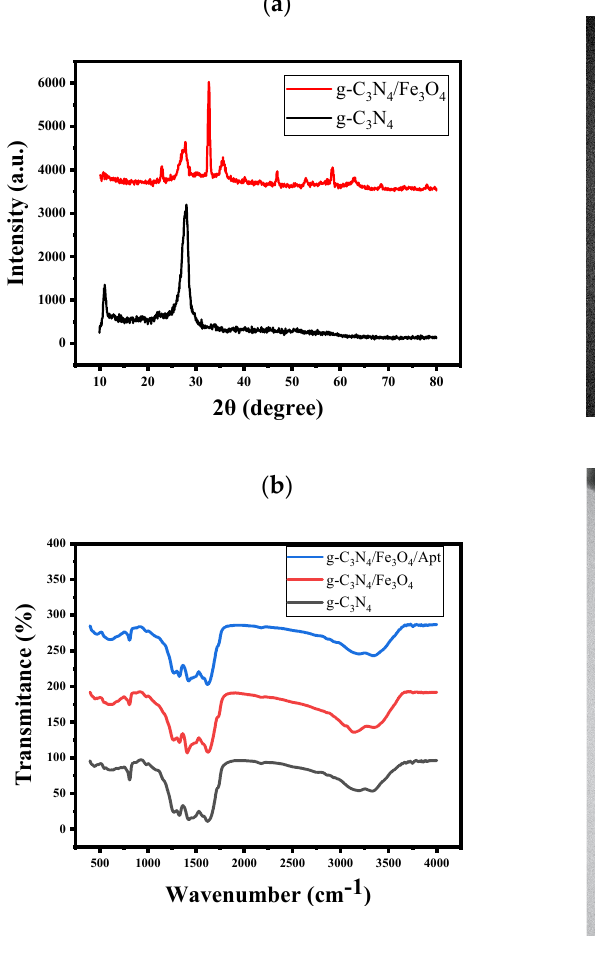
Figure 1. ( a ) X-Ray pattern of g-C 3 N 4 and g-C 3 N 4 /Fe 3 O 4 . ( b ) FTIR spectra of g-C 3 N 4 and g-C 3 N 4 /Fe 3 O 4 and g-C 3 N 4 /Fe 3 O 4 /Apt. ( c ) TEM image of g-C 3 N 4 and g-C 3 N 4 /Fe 3 O 4.